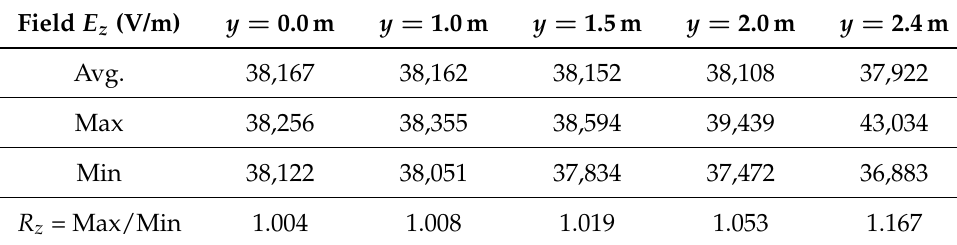
Table 1. Field variations in the TPC for the dual-anode design with 21 voltage strips per side. Field E z (V/m)